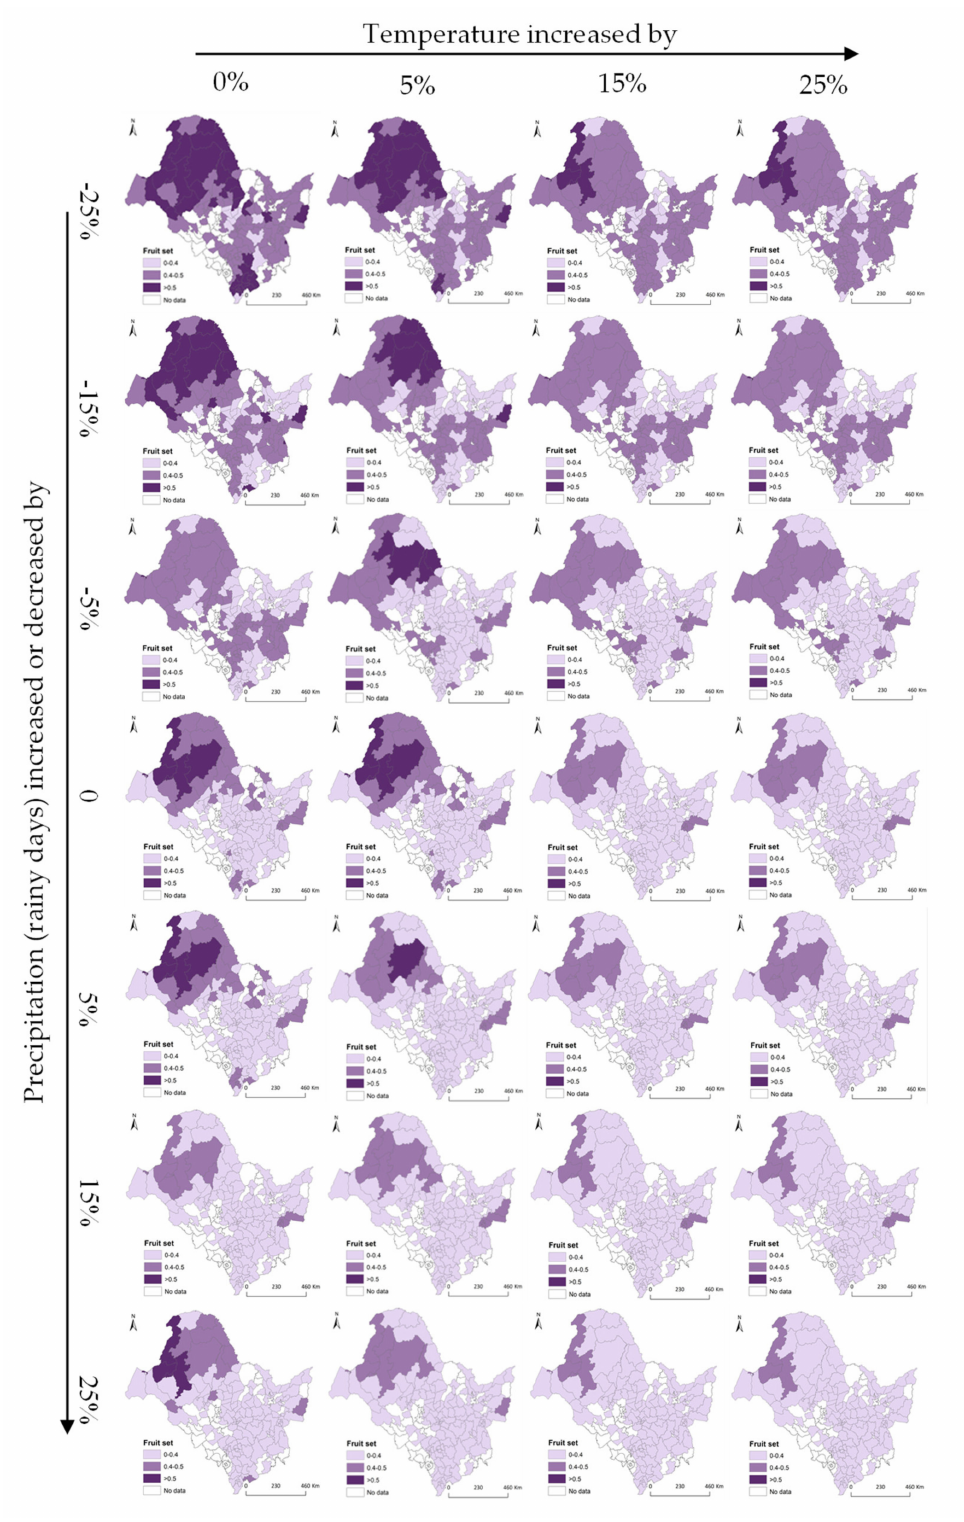
Figure 9. Fruit-set predictions in 151 bog blueberry production regions in Northeast China with increased temperatures and